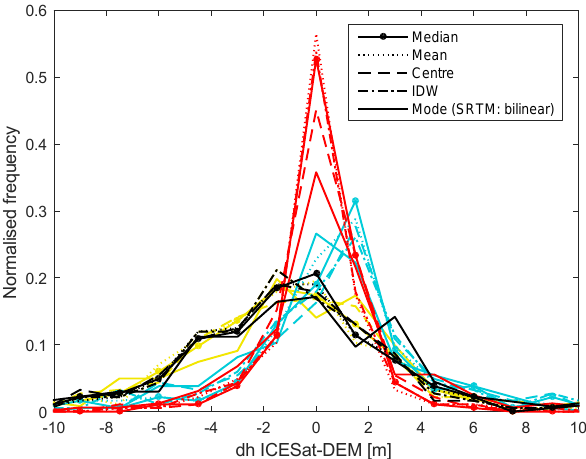
Figure 4. Graph shows dh from different reference DEMs and statistical measures to summarize elevations within footprints (184 land samples): lidar 2m (red), Kartverket 10m (black) and 20m (yellow), SRTM ∼ 90m (blue, bilinear interpolation shown in- stead of mode).